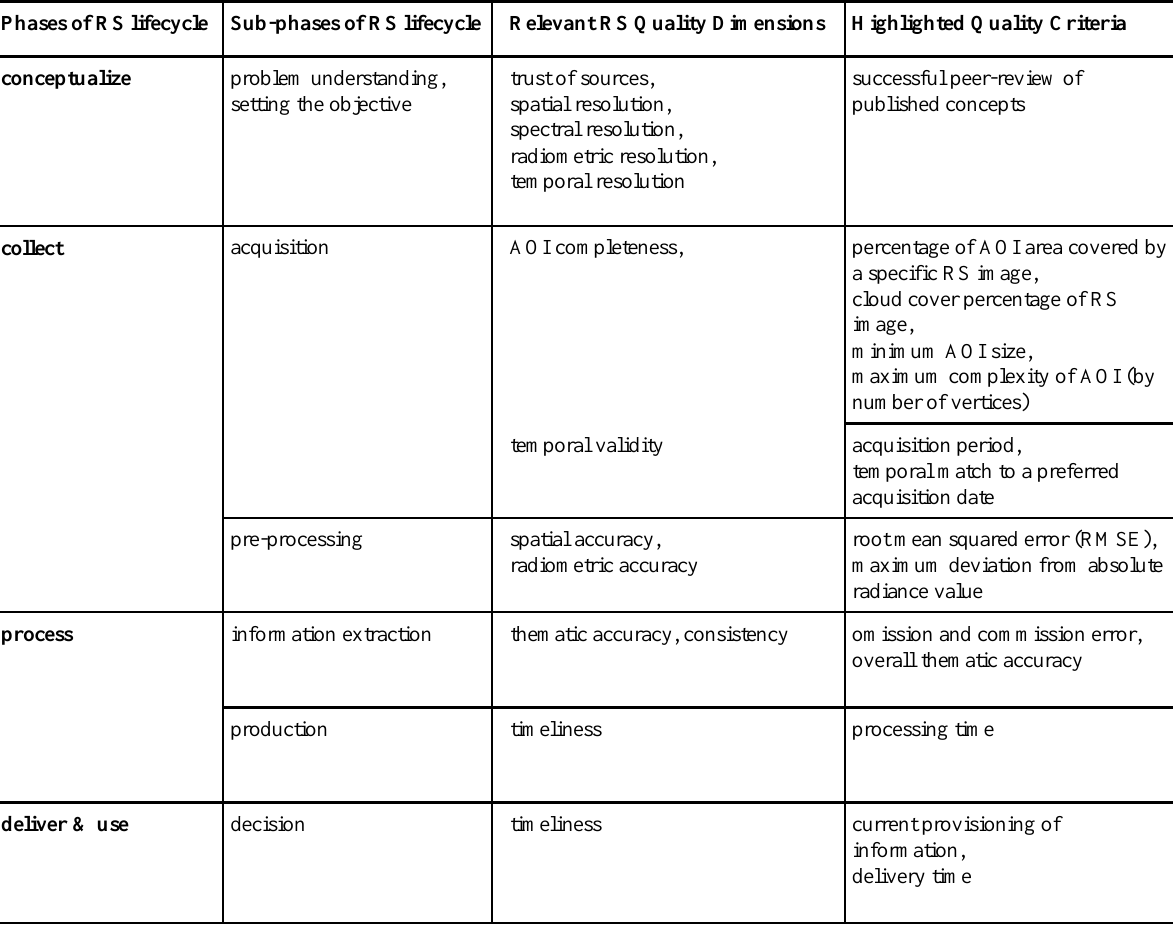
Table 1. Highlighted QC along the simplified RS lifecycle and their relation to RS